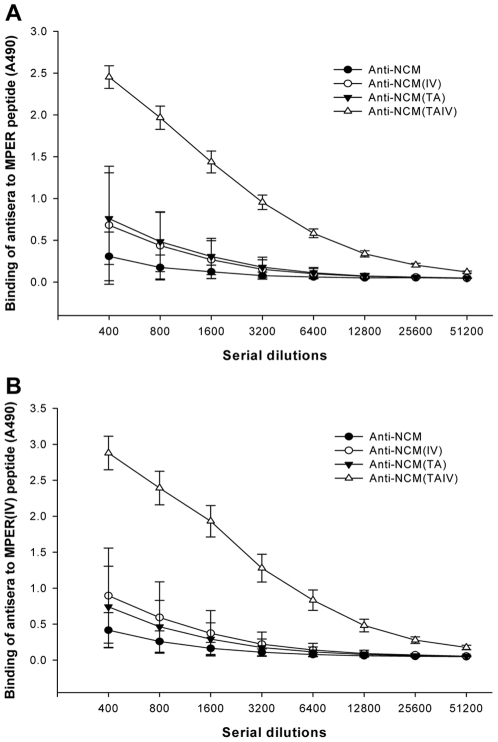
Binding of antisera to MPER or MPER(IV) peptide.Two-fold serially diluted rabbit sera were added to peptide MPER- (A) or MPER(IV) (B) -coated 96-well plates. Each datum is the average of A490 value of three rabbits in the same group.